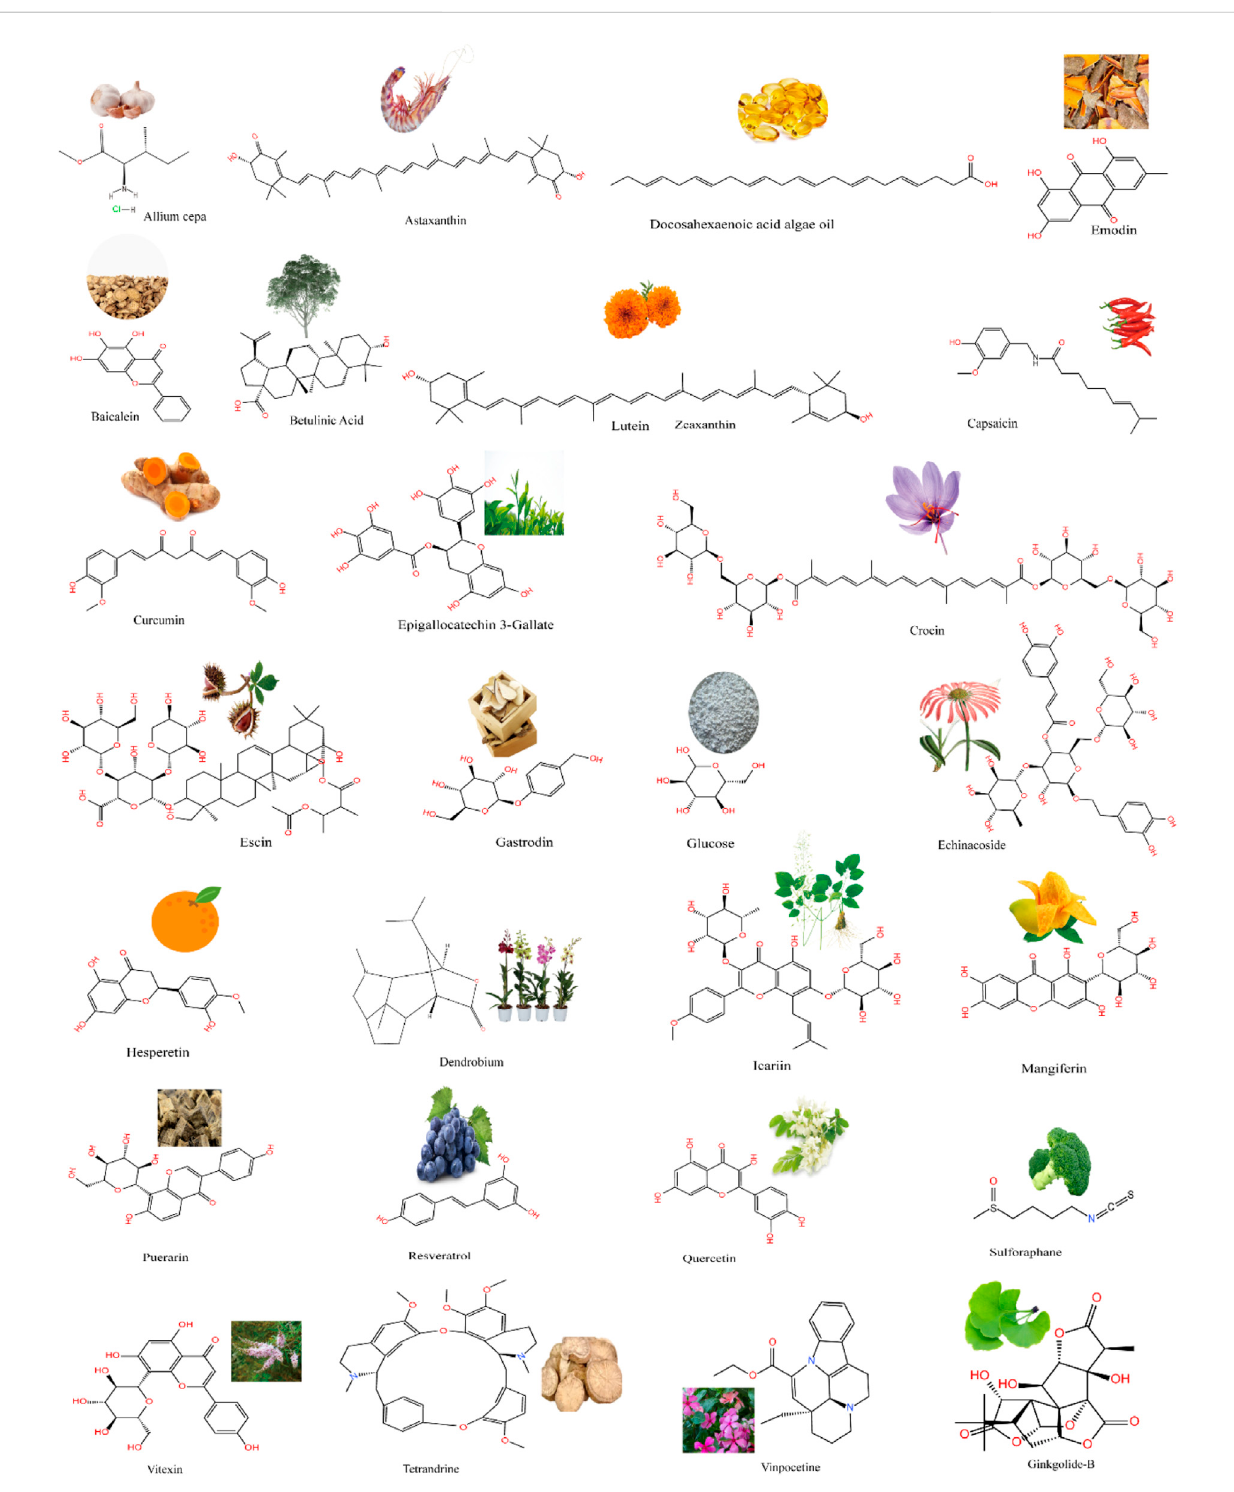
A wide range of natural products from plants and the structural formulae of natural chemical